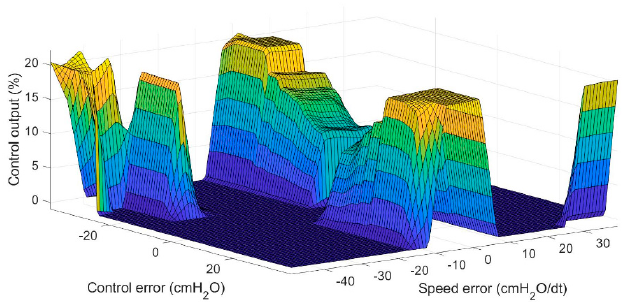
Figure 11. Process of training, testing and checking.